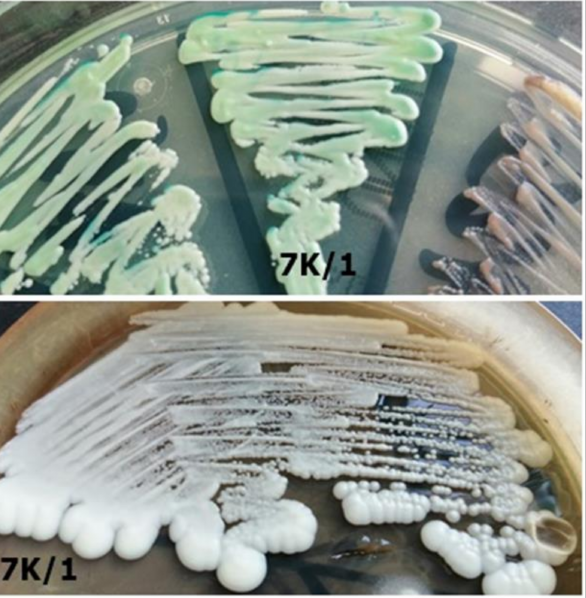
Figure 8. Strain 7K/1-morphology on CHROMagar Candida and Sabouraud 2 with chloramphenicol medium (private